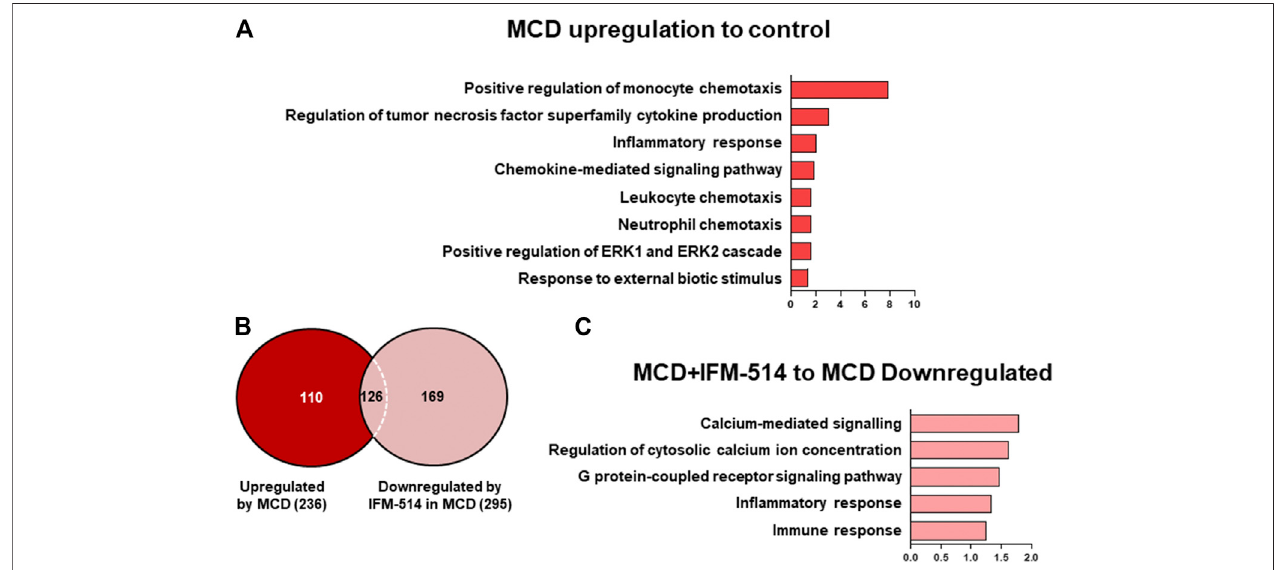
FIGURE 7 | Transcriptomic analysis of IFM-514-treated MCD-fed ApoE -/- mice. Gene ontology (GO) analysis and fold enrichment of genes of biological process upregulated in MCD-fed (A) . Venn diagram of downregulated genes in IFM-514-treated MCD-fed (B) . Enriched GO terms for genes downregulated in IFM-514-treated MCD-fed (C) . The signaling pathways are based on statistical signi fi cance. Genes were considered signi fi cantly down expressed ( p < 0.05) in IFM-treated mice by a minimum of 1.5 fold above that of vehicle-treated MCD-fed ApoE -/-